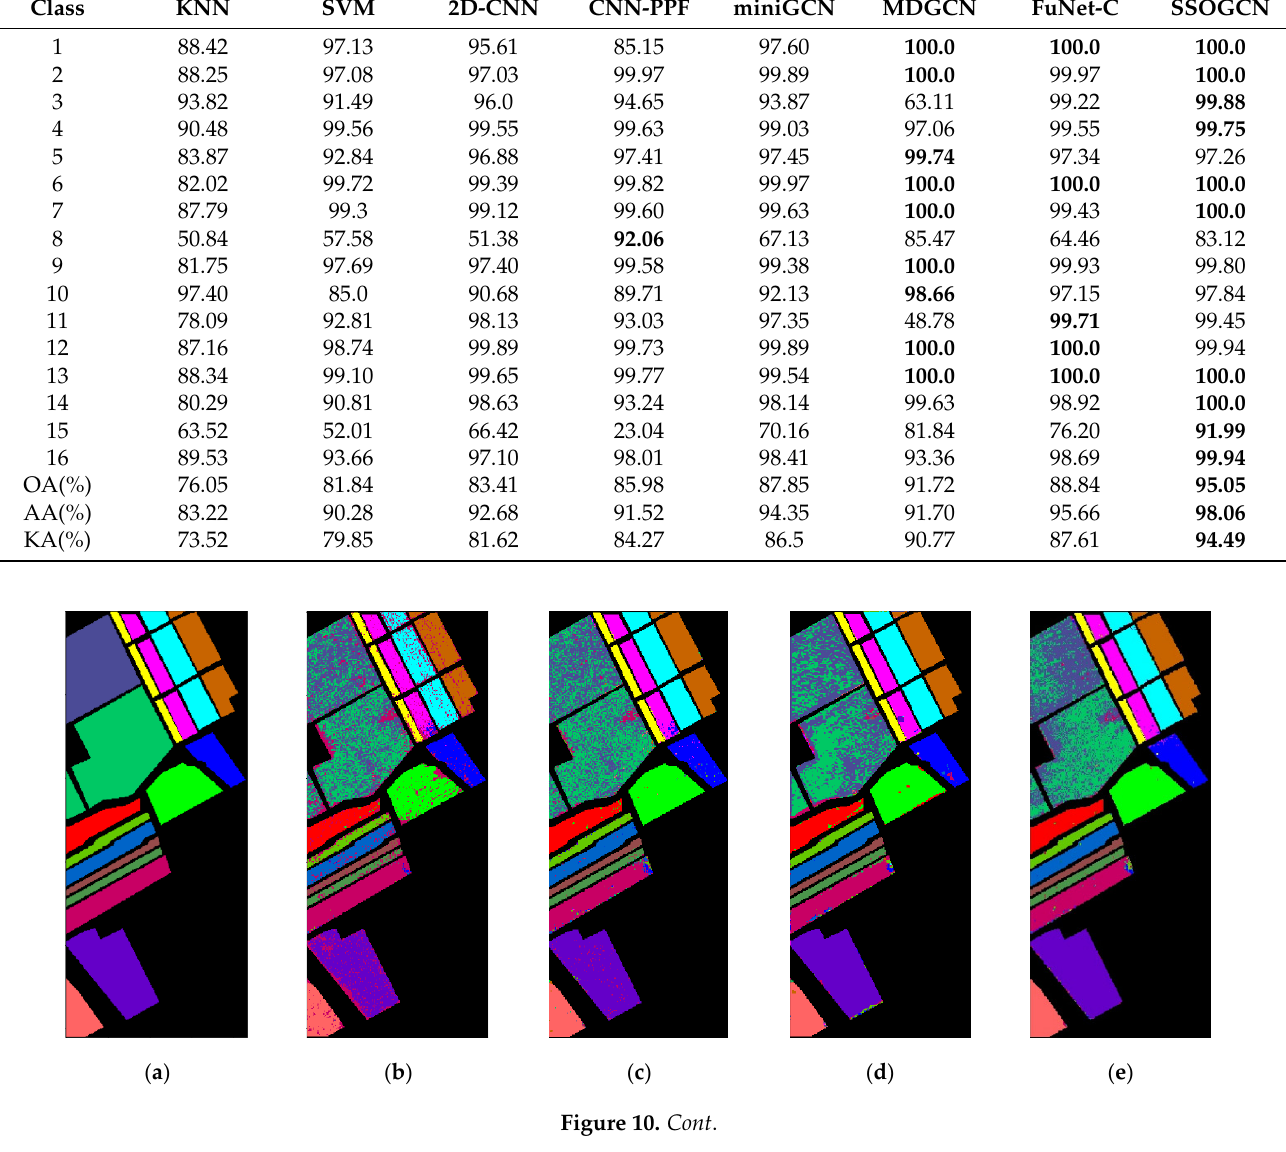
Table 7. Classification performance of various methods in Salinas data set (%).